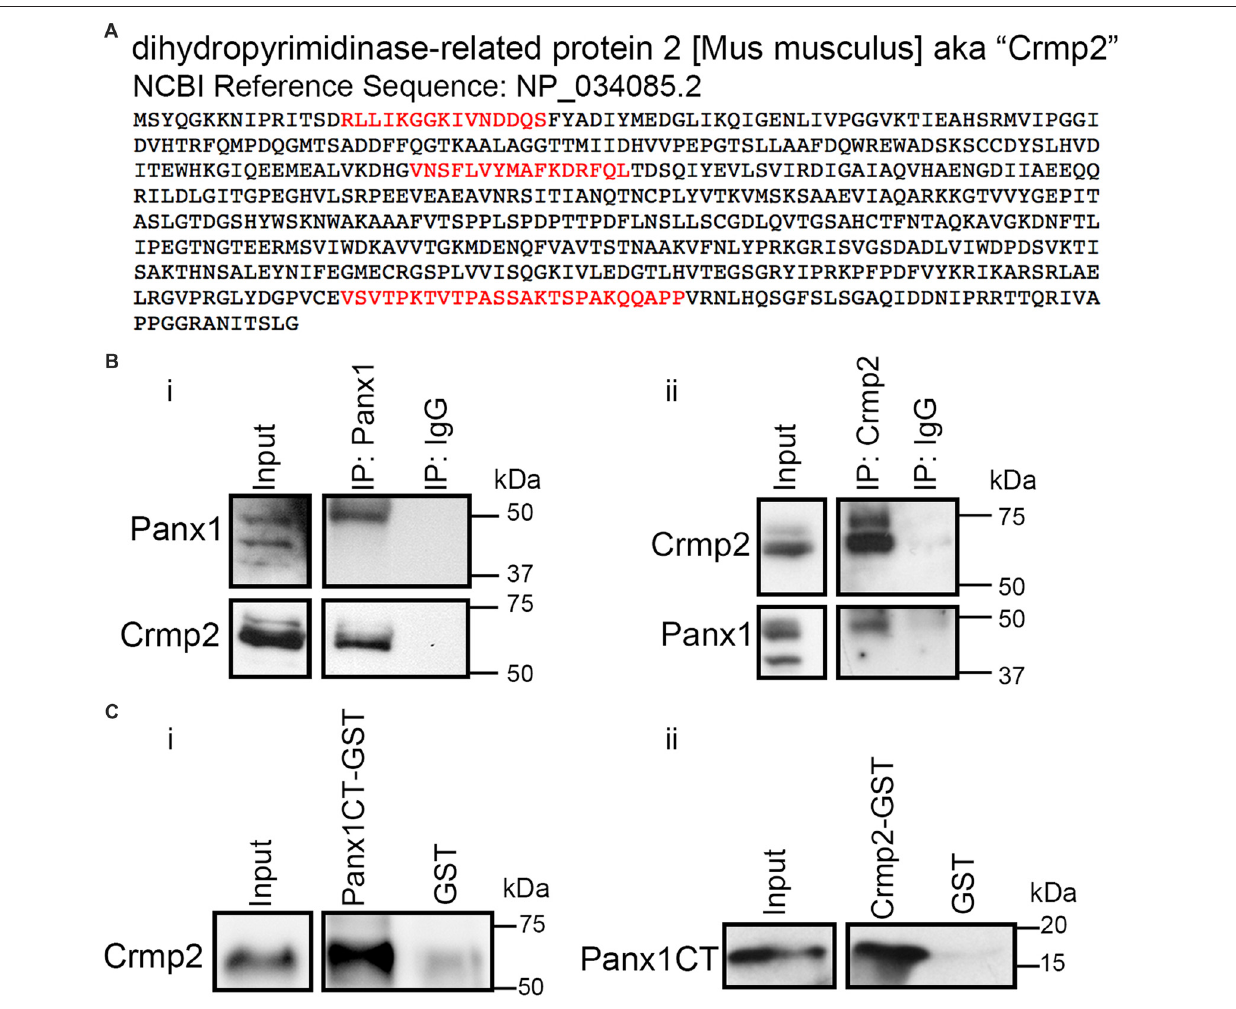
FIGURE 1 | Pannexin 1 (Panx1) and collapsin response mediator protein 2 (Crmp2) interact. (A) Crmp2 peptides (red) identified previously by immunoprecipitation (IP) coupled to LC-MS/MS in Wicki-Stordeur and Swayne (2013). Peptides were identified specifically in IPs from Panx1-EGFP expressing Neuro-2a (N2a) cells, and not EGFP controls. (B) Western blot of endogenous IPs from N2a cell lysates. (i) Crmp2 precipitates specifically with Panx1 compared with IgG control. (ii) Panx1 precipitates specifically with Crmp2 compared with IgG control. (C) Western blots of an in vitro binding assay using purified Crmp2 and Panx1 C-terminus (Panx1CT). (i) The Panx1CT enriches with immobilized Crmp2-GST compared with GST control. (ii) Crmp2 enriches with Panx1CT-GST compared with GST control. These results are representative of three independent replicates. For the complete blots of parts (B,C) , see Supplementary Material. This data was previously included in the PhD thesis of LWS (link: